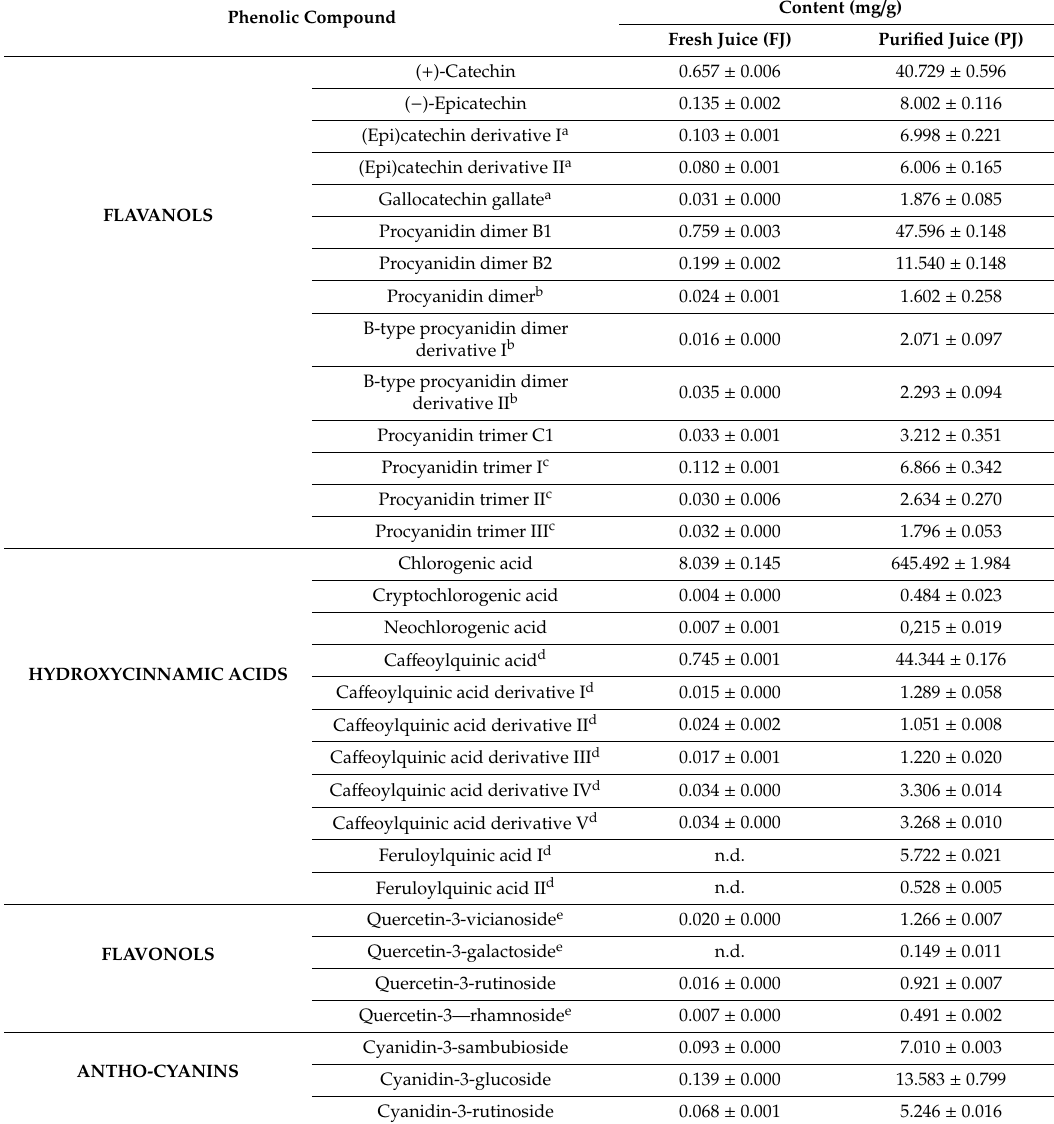
Table 1. Phenolic compound contents in fresh juice and purified juice of Viburnum opulus